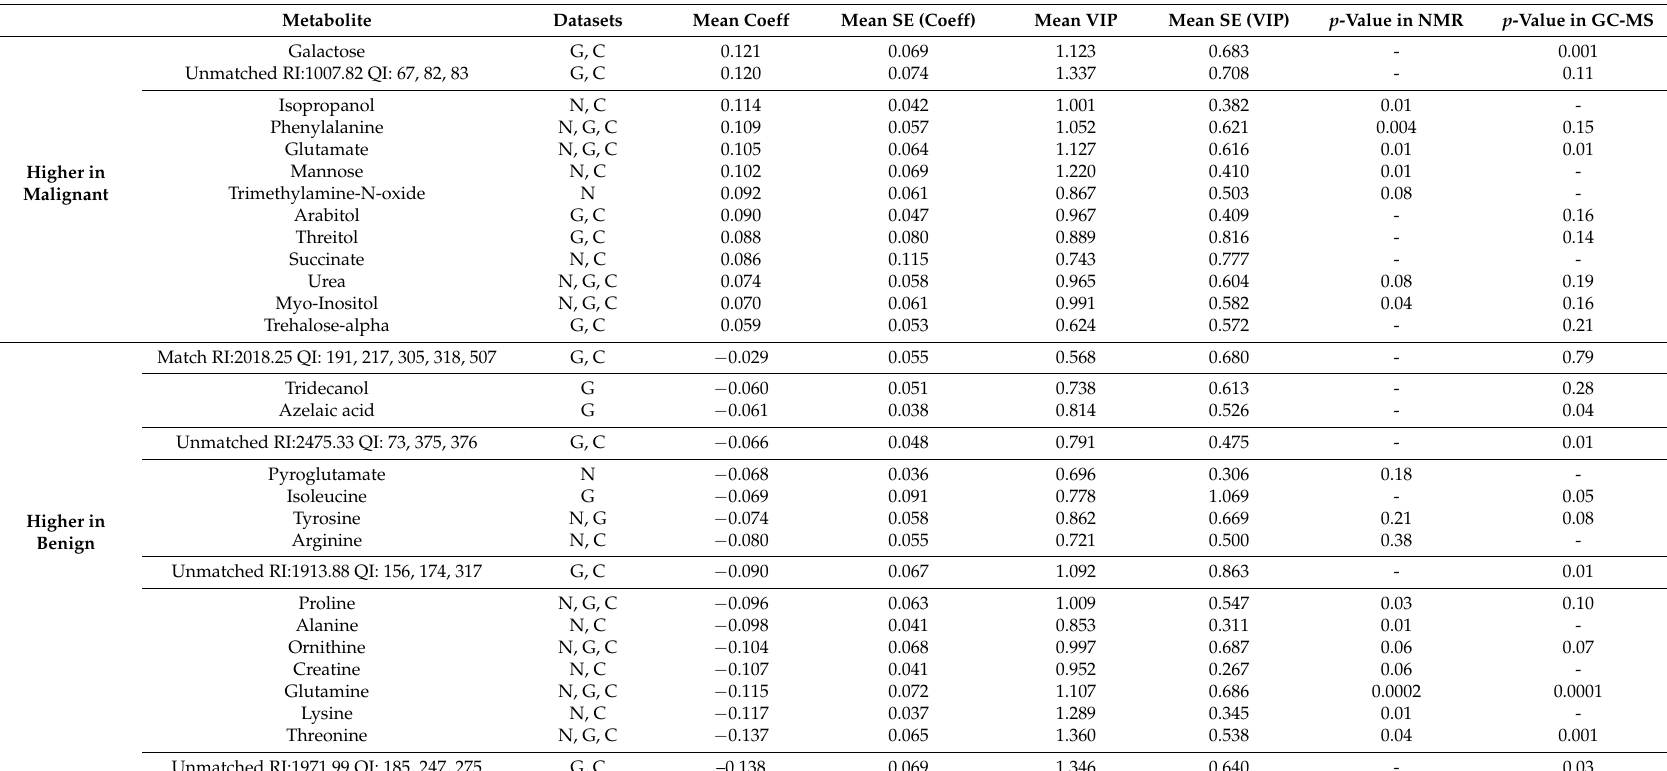
Table 3. Summary list of metabolite features included in final focused